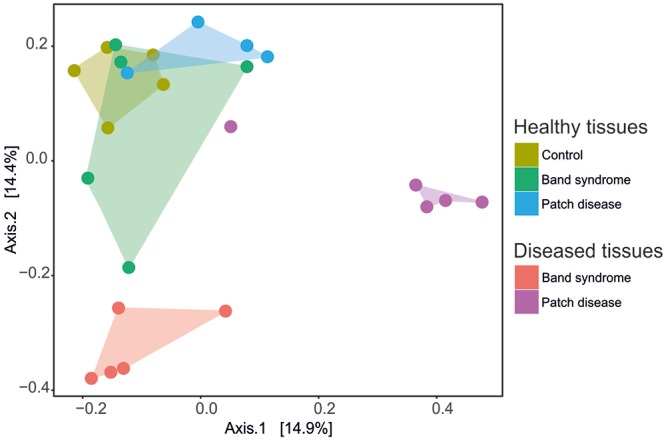
Multi-dimensional scaling plot (MDS) based on the Bray–Curtis similarity index showing the similarity between bacterial community compositions for healthy and diseased tissues in CCA affected by CWBS and CWPD.